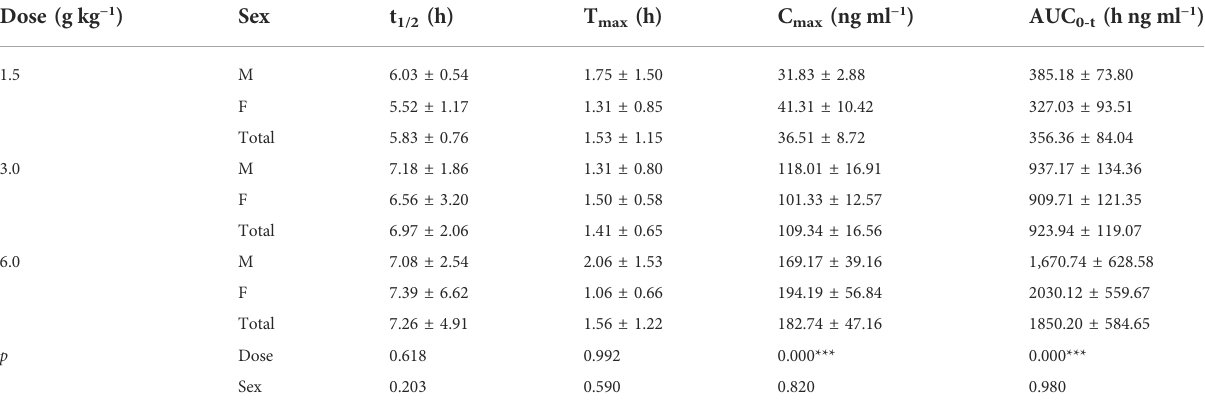
TABLE 1 Pharmacokinetic parameters of agarotetrol after different doses of TYZB in rats (D1). Dose (g kg − 1 ) Sex